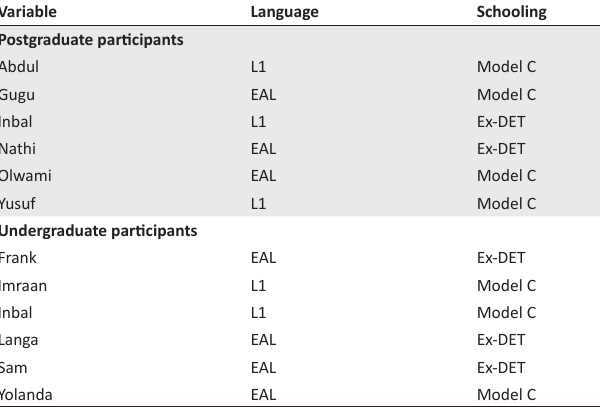
TABLE 1: Overview of participants’ educational and language